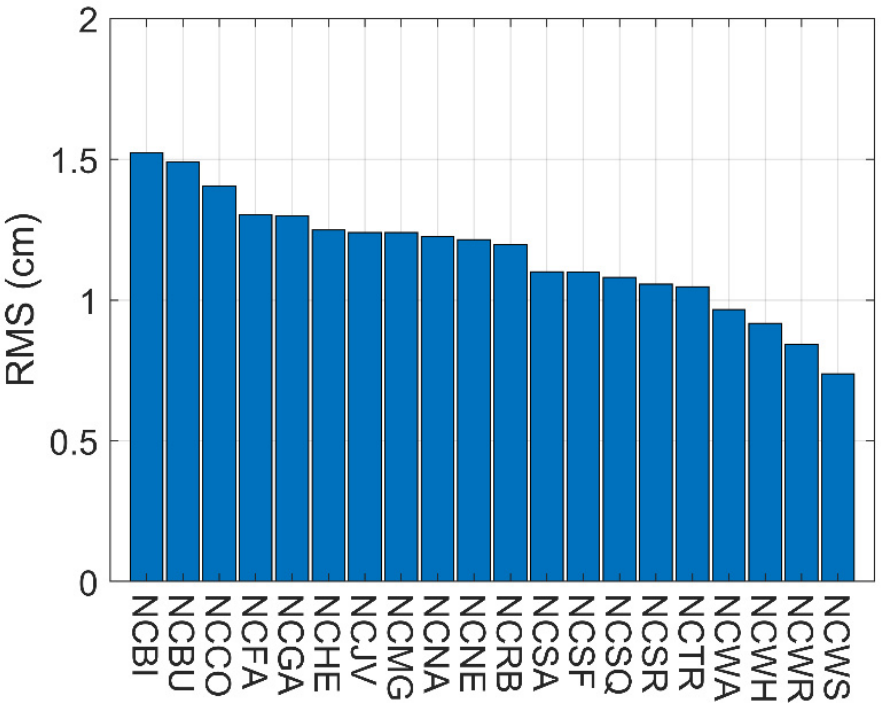
Figure 2. RMS of the tropospheric corrections at each user station compared to the estimated tropospheric delay at the same station.